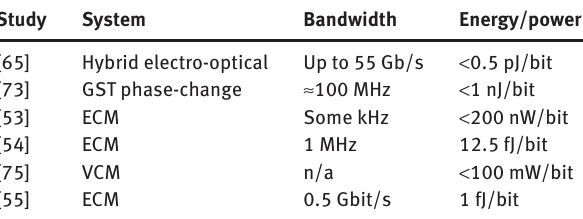
Table 1: Comparison of the studies demonstrated optically accessible platforms for computing or memory operations based on hybrid electro-optical devices, phase change, or redox-based memristive